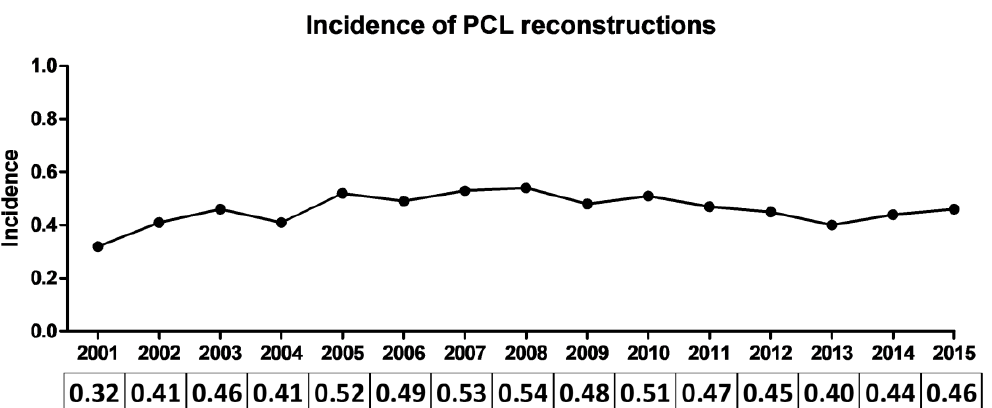
Figure 1. Incidences of posterior cruciate ligament (PCL) reconstructions (number of surgeries per 100,000 inhabitants) in the Italian population over the 15-year study period.